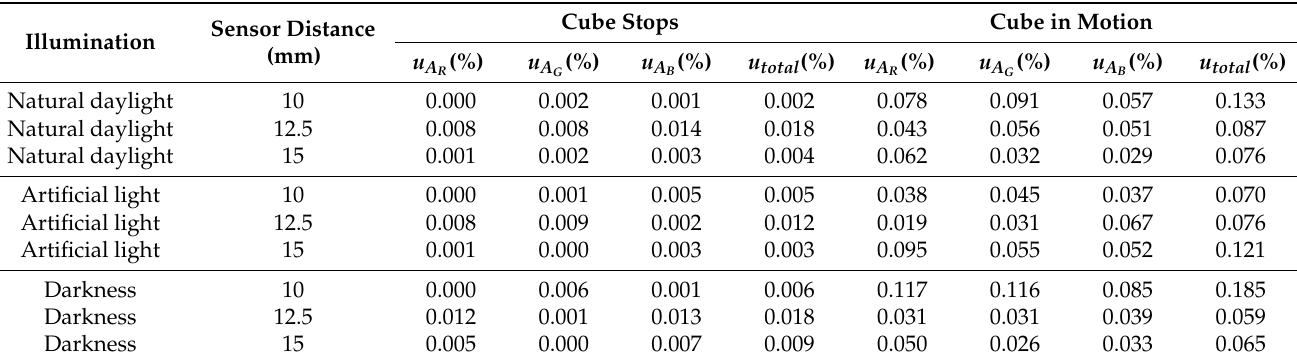
Table 9. Type A standard uncertainty for a brown